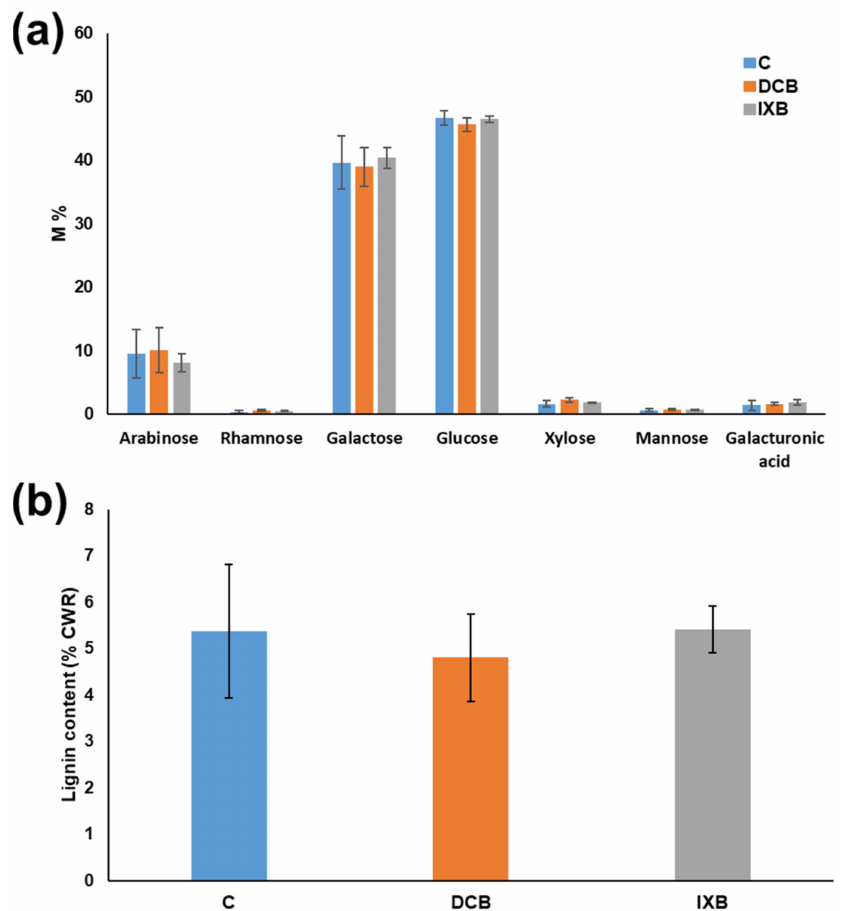
Figure 4. Monosaccharide composition ( a ) and total lignin content ( b ) of the cell wall residue of control (indicated with C) and habituated cells (indicated with DCB and IXB). Values are expressed as the mean ± standard deviation (SD) from four independent biological replicates. No statistically sig- nificant differences were computed for all the sugars analyzed (no letters are present on the bars). Ara- binose [F(2,9) = 0.30, p -value = 0.746], Galactose [F(2,9) = 0.22, p -value = 0.810], Glucose [F(2,9) = 1.29, p -value = 0.322], Xylose [F(2,9) = 3.02, p -value = 0.099], Mannose [F(2,9) = 1.26, p -value =